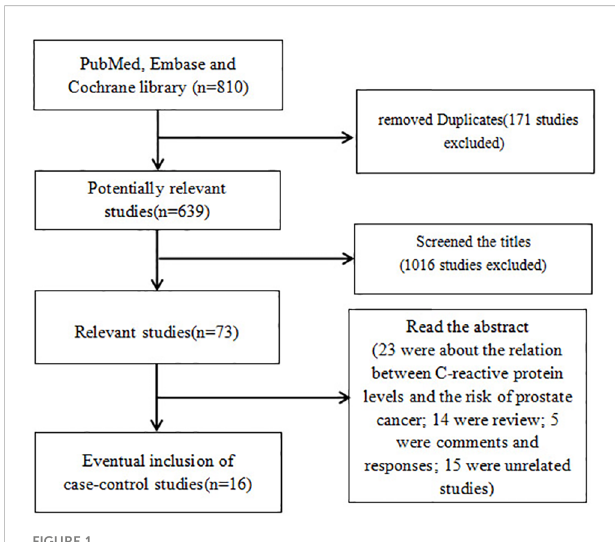
FIGURE 1 Flowchart illustrating the search strategy for CRP and prognosis in prostate cancer. CRP, C-reactive